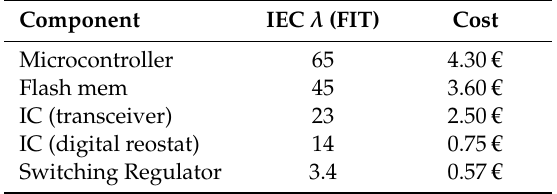
Table 5. Failure rate and cost of some components of the Control_new